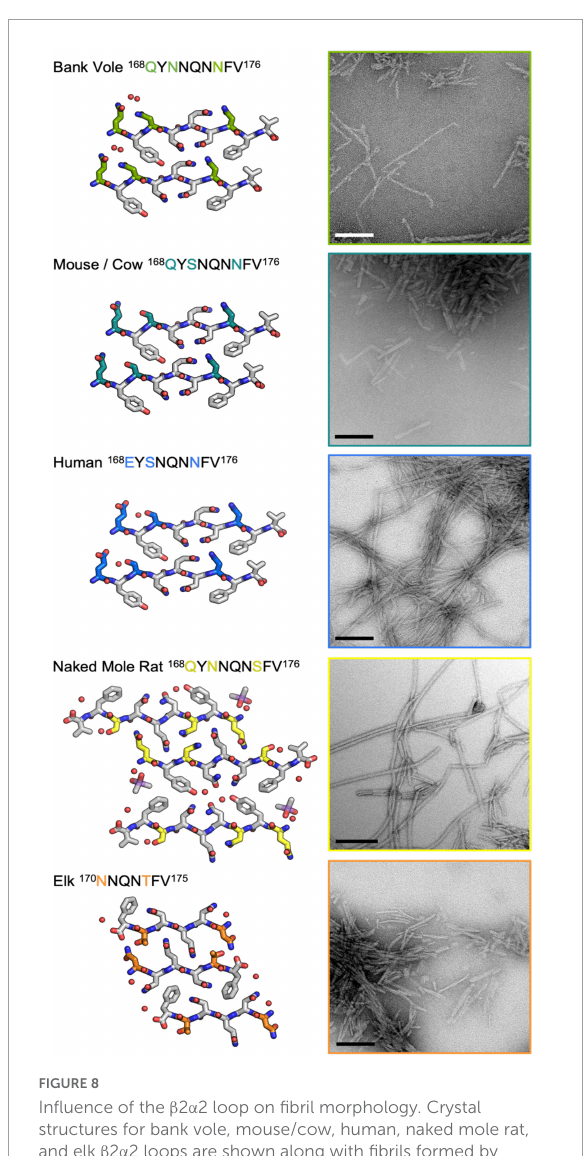
FIGURE8 Influence of the β 2 α 2 loop on fibril morphology. Crystal structures for bank vole, mouse/cow, human, naked mole rat, and elk β 2 α 2 loops are shown along with fibrils formed by rBvPrP 94 - 178 harboring the loop substitutions in residues 168-176 belonging to each species. Scalebars =